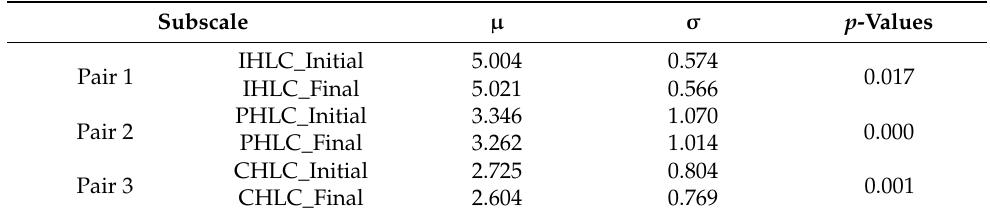
Table 8. Changes in user response to the MHLC subscales within the six-week period between user surveys ( n = 40). Subscale